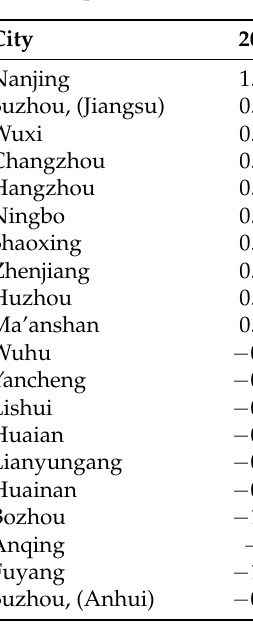
Table 6. Top 10 and bottom 10 cities in urbanization